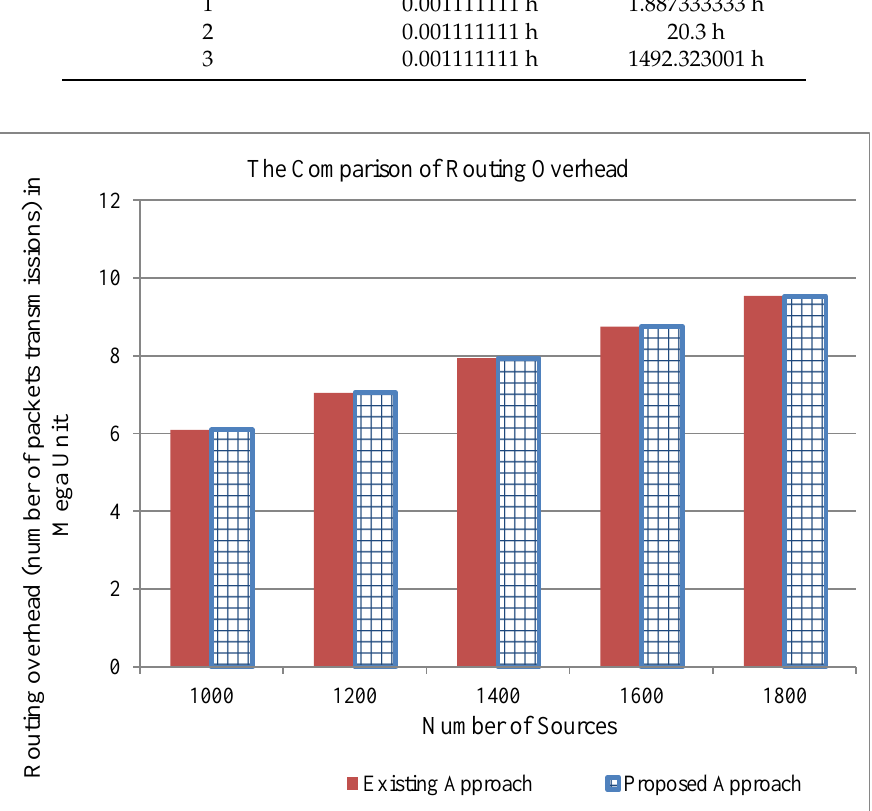
Figure 4. The comparison of traffic overhead of the existing and proposed approaches for one cache